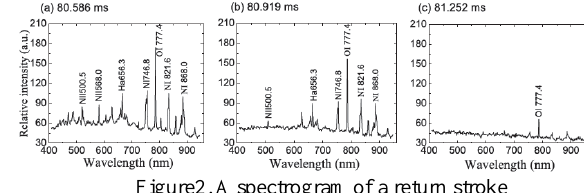
Figure2. A spectrogram of a return stroke